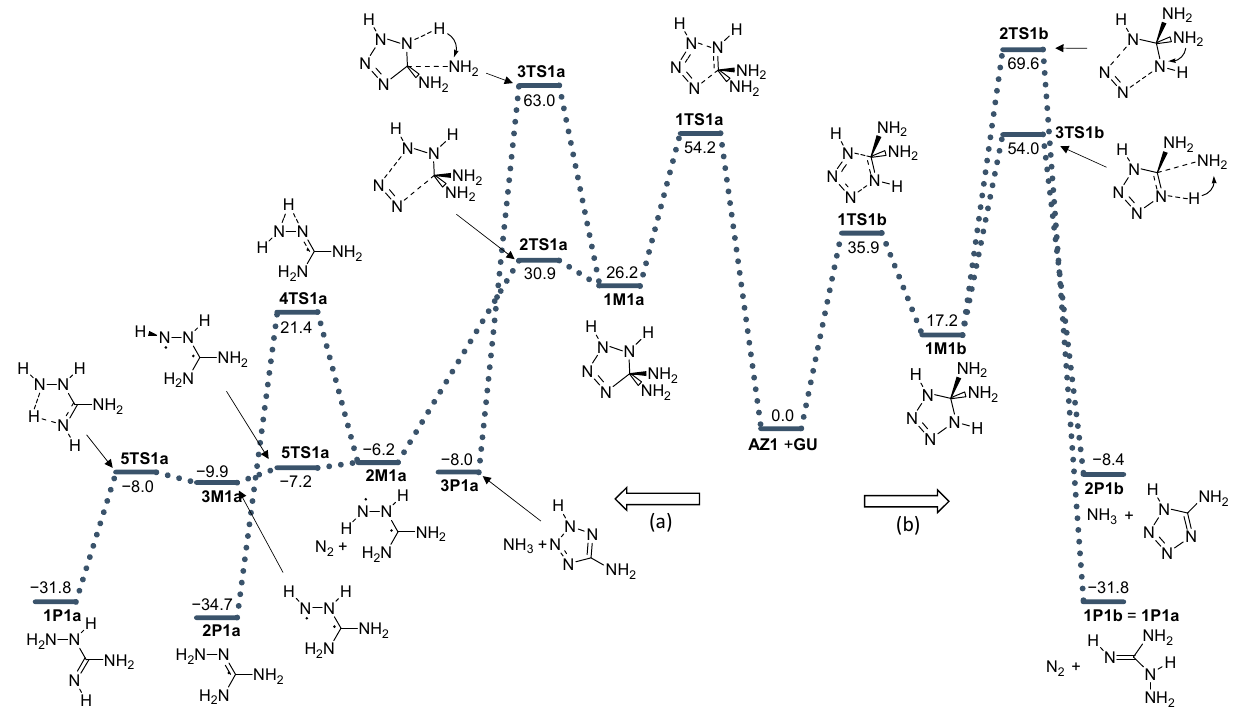
Figure 3. Energy profile for the addition of azide AZ1 with guanidine GU . Energies relative to reactants are given in kcal mol − 1 . ( a ) and ( b ) denote two modes of azide addition to GU . The effect on the reactivity of azide substitution obtained by different functional groups was examined by the introduction of methyl ( AZ2 ), phenyl ( AZ3 ), benzyl ( AZ4 ), and perfluorophenyl ( AZ5 ) groups to the azide functionality. The energy profiles of these reactions are given in Figures 4–7.